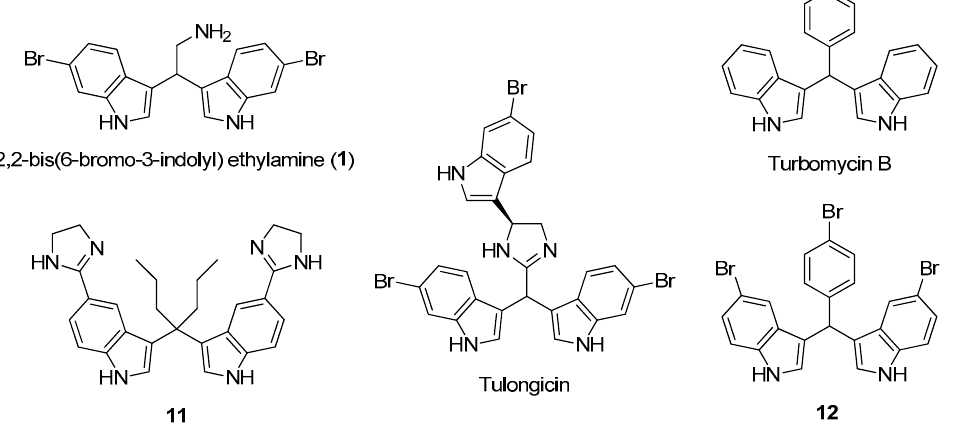
Figure 1. The marine alkaloid 1, some natural and synthetic antibacterial agents having the 3,3’-diindolylmethane (DIM) molecular unit.